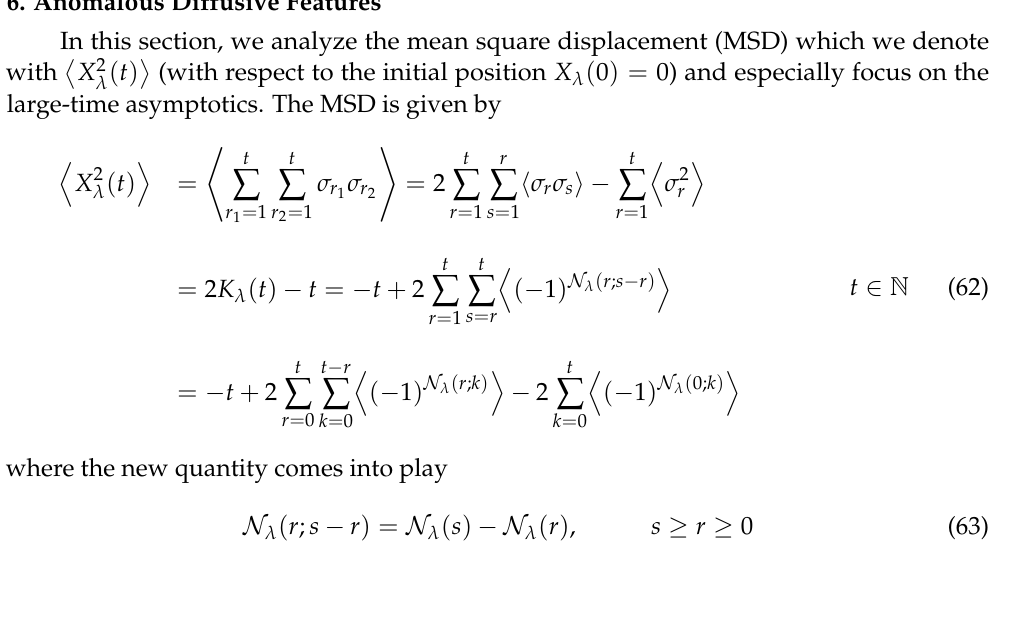
Figure 2. Large-time behavior of the expected position (61) for λ < 3 λ = 3 (red curve) corresponds to an asymptotically unbiased walk with (cid:104) X 3 2 denote (cid:104) X λ ( ∞ ) (cid:105)